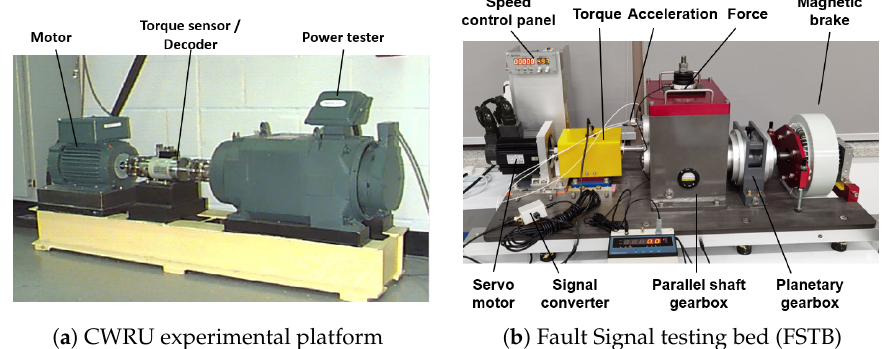
Figure 7. Bearing experimental platforms. Sub-figure ( a ) indicates the experimental platform of Case Western Reserve University and sub-figure ( b ) is the fault signal testing